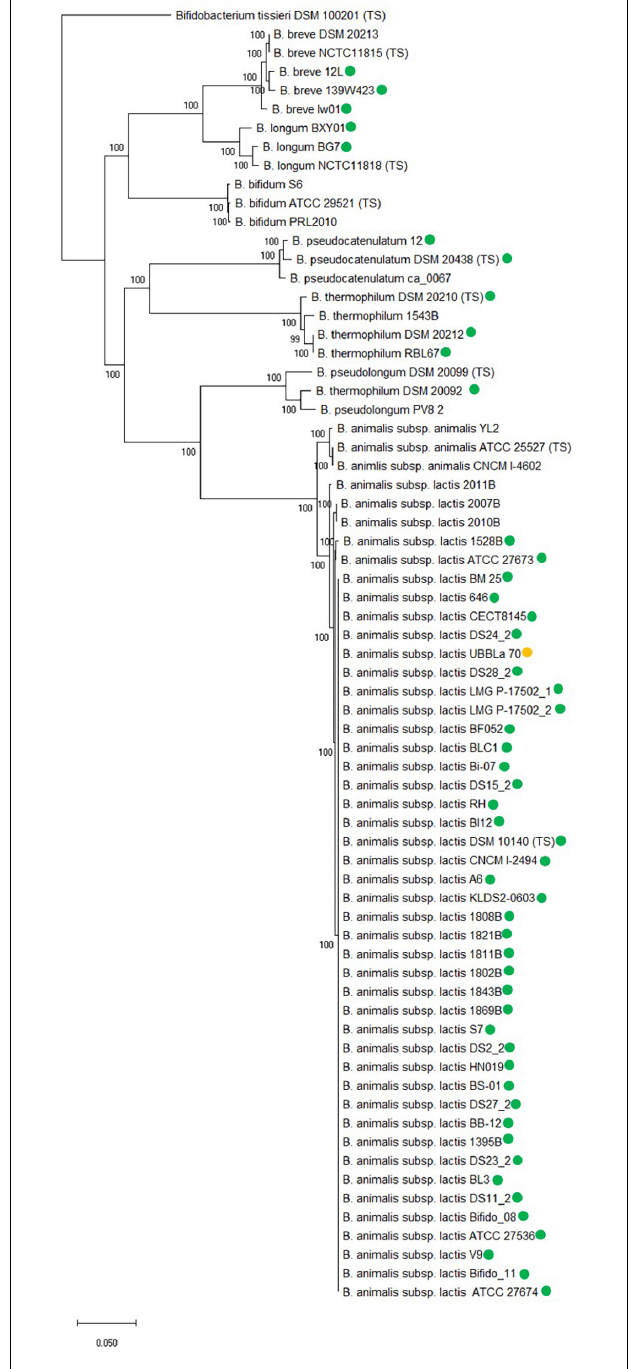
FIGURE 3 | Core genome phylogenetic tree based on 250 core genes which include B. animalis subsp. lactis strains and other related Bifidobacterium species. Type strain has been included for each species, designated TS and strains both with and without tet (W) are included for each species, except for B. animalis subsp. animalis and B. bifidum . tet (W) positive strains are marked with a green circle. B. animalis subsp. lactis UBBLa 70 exhibit a tet (W) gene with large deletions and is marked with a yellow circle. The tree is rooted with the Bifidobacterium tissieri type strain DSM 100201 as an outgroup (Lugli et al., 2018). Bootstrap percentages are shown at node